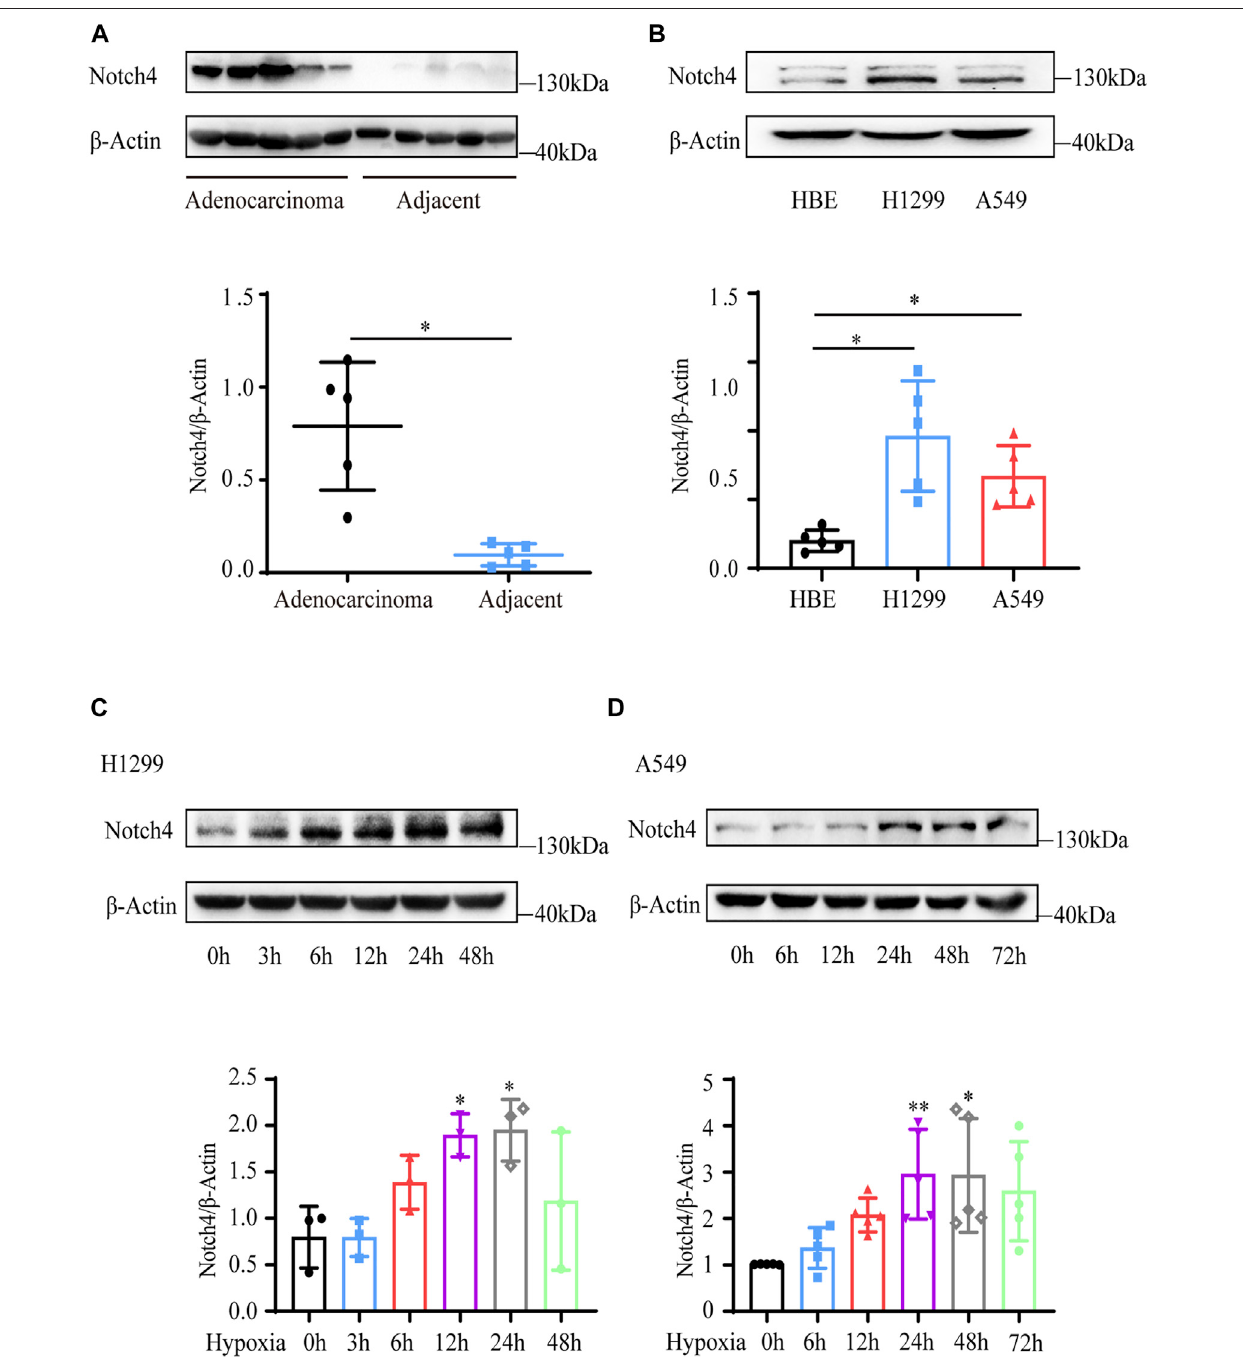
FIGURE 1 | Notch4 is upregulated in LUAD tissues and cells. (A) The protein level of Notch4 in fi ve paired LUAD tissues and adjacent non-malignant tissues. (B) The protein levels ofNotch4inA549and H1299 cellsand normal HBE cell. ( n (cid:2) 8). (C) Theprotein levelsofNotch4 inH1299cells exposed tohypoxia fordifferenttimes. ( n (cid:2) 3). (D) The protein levels of Notch4 in A549 cells exposed to hypoxia for different times. ( n (cid:2) 5). Data were presented as means ± SD. * p < 0.05, ** p < 0.01. LUAD, lung adenocarcinoma; HBE, human bronchial epithelial.